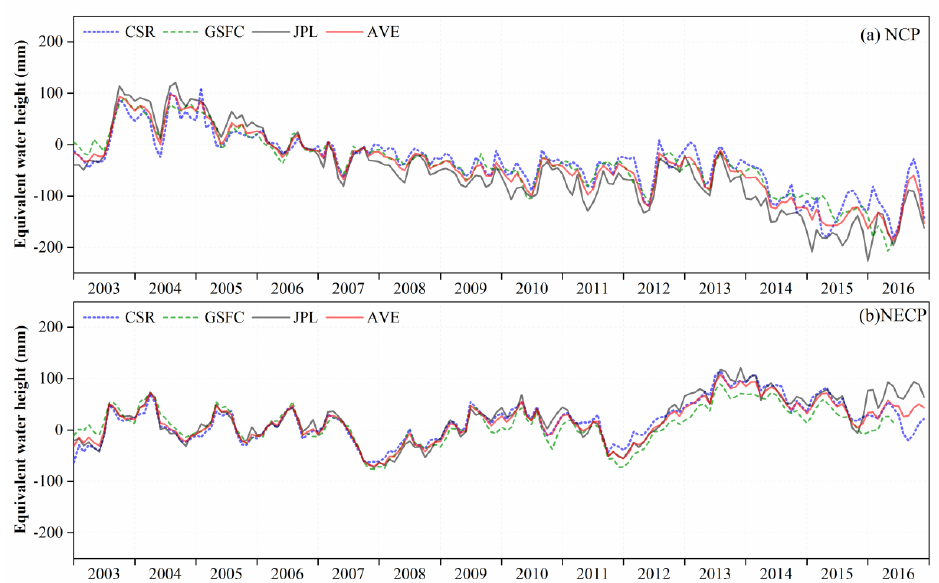
Figure 2. Time series of total water storage anomalies (TWSA) estimated from the Center for Space Research (CSR), Goddard Space Flight Center (GSFC), and Jet Propulsion Laboratory (JPL) mascon solutions and their average (AVE) in the North China Plain (NCP) ( a ) and the Northeast China Plain (NECP) ( b ).